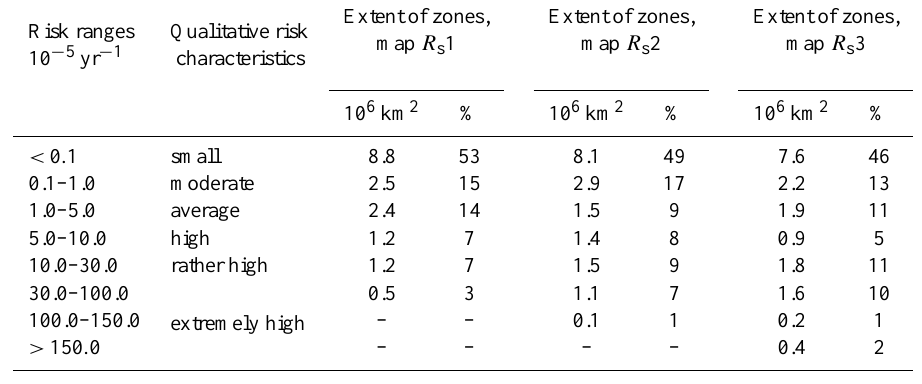
Table 2. Values of individual seismic risk and extent of zones with different risk levels.